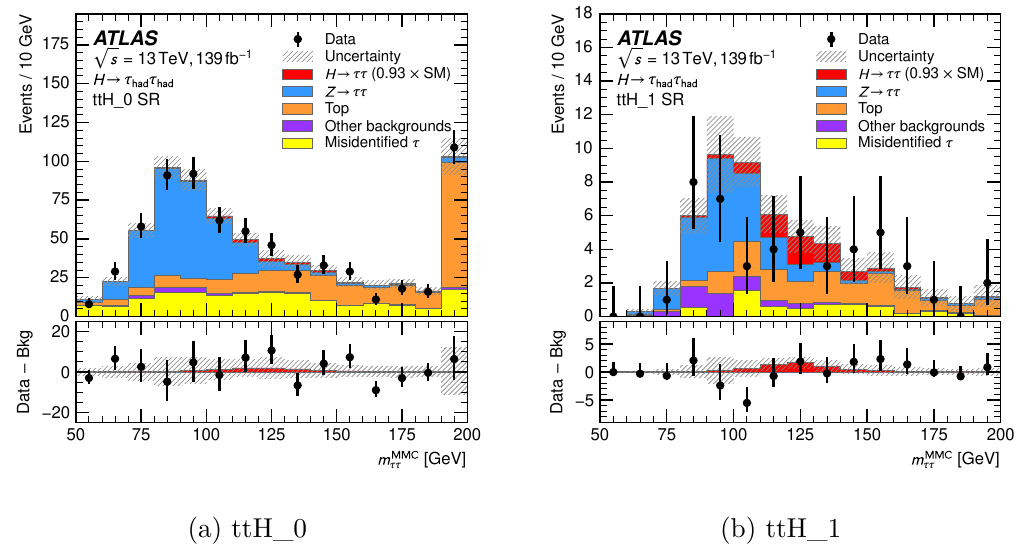
Figure 11. Distribution of the reconstructed ττ invariant mass ( m MMC ttH_0 and (b) ttH_1 categories of the τ between the numbers of observed data events and expected background events (black points). The observed Higgs boson signal, corresponding to ( σ × B ) / ( σ × B ) histogram. Entries with values above the x -axis range are shown in the last bin of each distributions. The dashed band indicates the total uncertainty on the total predicted yields. The prediction for each sample is determined from the likelihood fit performed to measure the pp → H → ττ